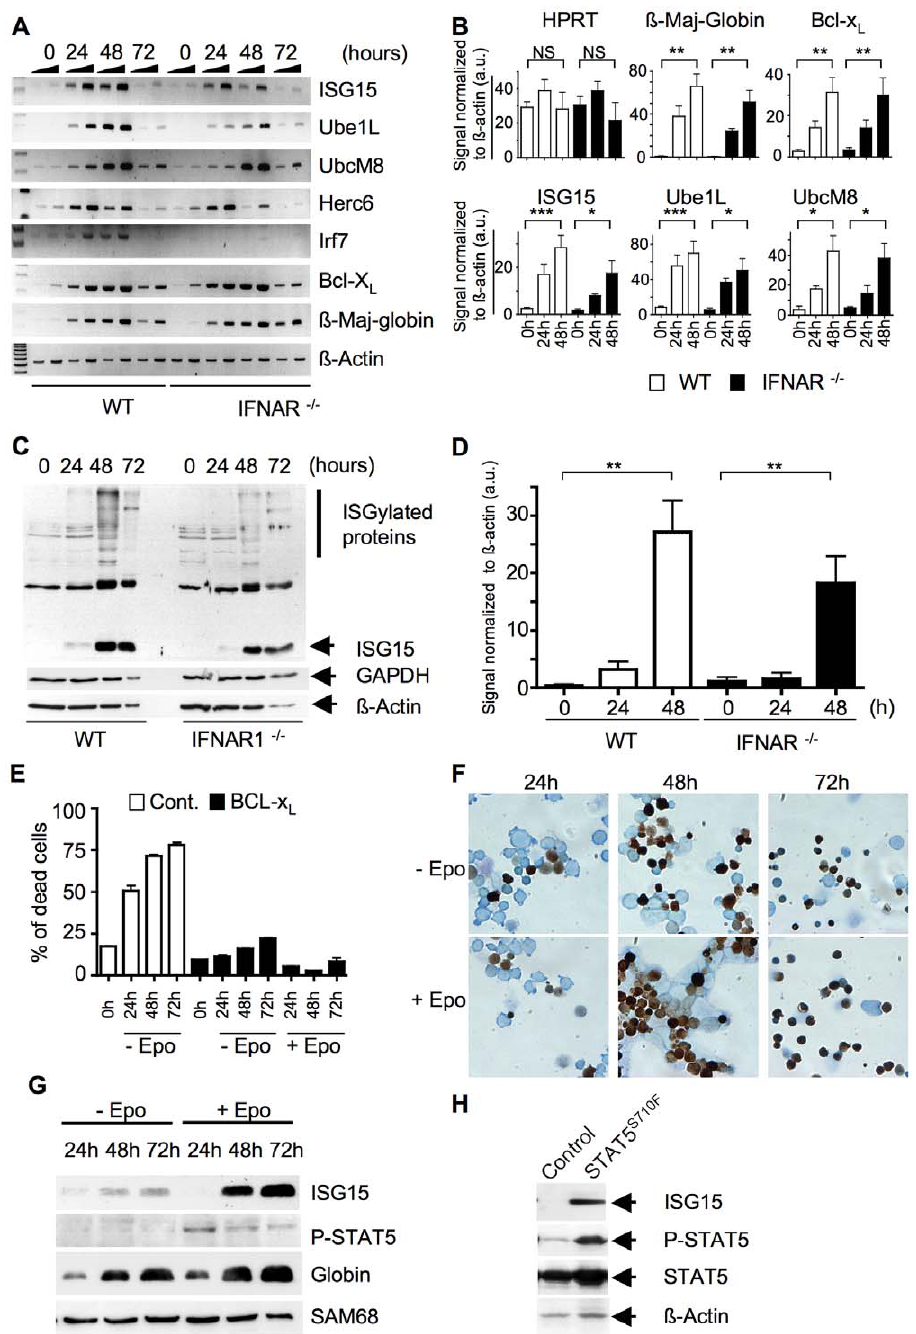
Figure 2. ISG15 expression during erythroid differentiation is independent of IFN signaling and partially dependent upon Epo signaling. ( A ) semi-quantitative RT-PCR analyses of ISG15, Ube1L, UbcM8, Herc6, Irf7, Bcl-x L and ß-Major-Globin mRNA expression in WT or IFNAR -/- differentiating primary erythroblasts. Bone marrow erythroblasts of each genotype were maintained in proliferation conditions (SCF, Epo and Dex) for one week and next induced to differentiate in response to Epo alone for three days. Cells were collected every 24 hours as indicated and RNA extracted. The experiment was normalized to ß-Actin mRNA expression. ( B ) Statistical analysis of the induction of the expression of ß-Maj-Globin, Bcl- X L , ISG15 , Ube1L , UbcM8 and Herc6 mRNA in differentiating WT and IFNAR -/- erythroblasts. Quantification was performed as described in Mat & Met. Note the unchanged expression of a second housekeeping gene HPRT . au=arbitrary unit. ( C ) Whole cell protein extracts were prepared from WT or IFNAR -/- erythroblasts maintained as in A and analyzed on a 10% acrylamide gel for ISG15 expression using an anti-ISG15 antibody. Anti-ß-Actin and anti-GAPDH were used as loading controls. ( D ) Statistical analysis of the induction of ISG15 during erythroid differentiation as normalized to ß-Actin. Quantification was performed as described in Mat & Met. au=arbitrary unit. ( E and F ) A p53 -/- erythroid cell line expressing exogenous hBcl-X L was switched from proliferation conditions (Epo, SCF, Dex) to differentiating medium in the presence or absence of Epo. Cells were collected every 24 hours as indicated and analyzed for their ability to (e) survive as measured by propidium iodide staining in flow cytometry analyses; (f) differentiate as shown by analysis of their morphology after benzidine/May-Grunwald staining. Note the significant induction of cell death in control cells maintained in absence of Epo; in contrast, hBCL-xL erythroblasts are strongly protected from apoptosis. ( G ) Cells were lyzed according to cell